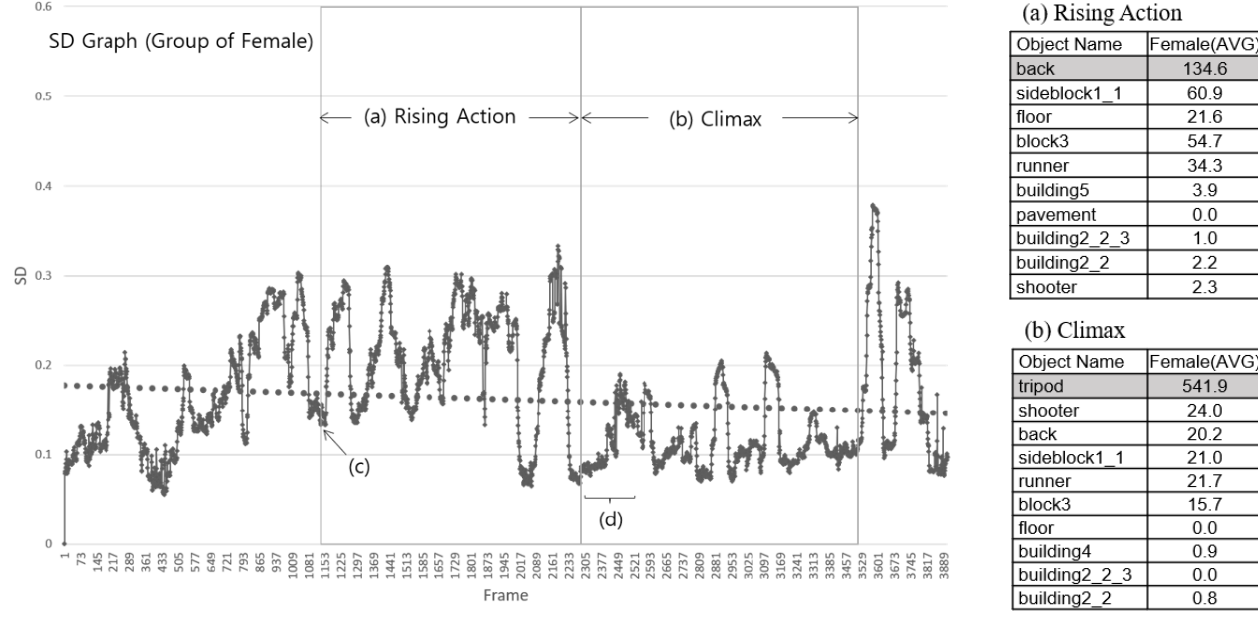
Figure 9. Female group in the Rising Action and Climax (Standard Deviation ( left ) and Objects Most Seen ( right )).